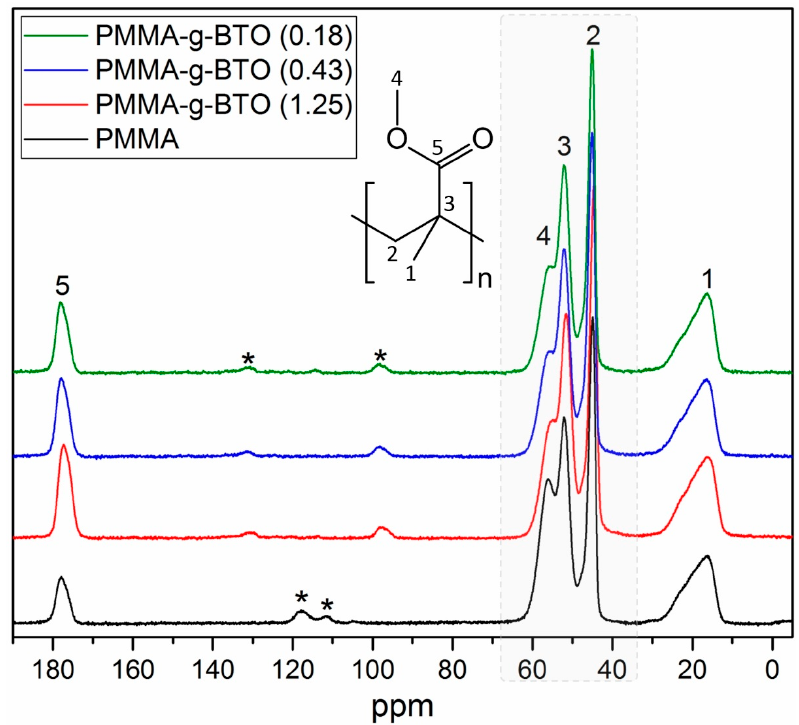
Figure 5. Comparison of the 13 C CP/MAS NMR spectra recorded for BTO- g -PMMA (0.18)—(green), BTO- g -PMMA (0.43)—(blue), BTO- g -PMMA (1.25)—(red) and neat PMMA—(black). Signals marked with asterisks indicate rotational sidebands.